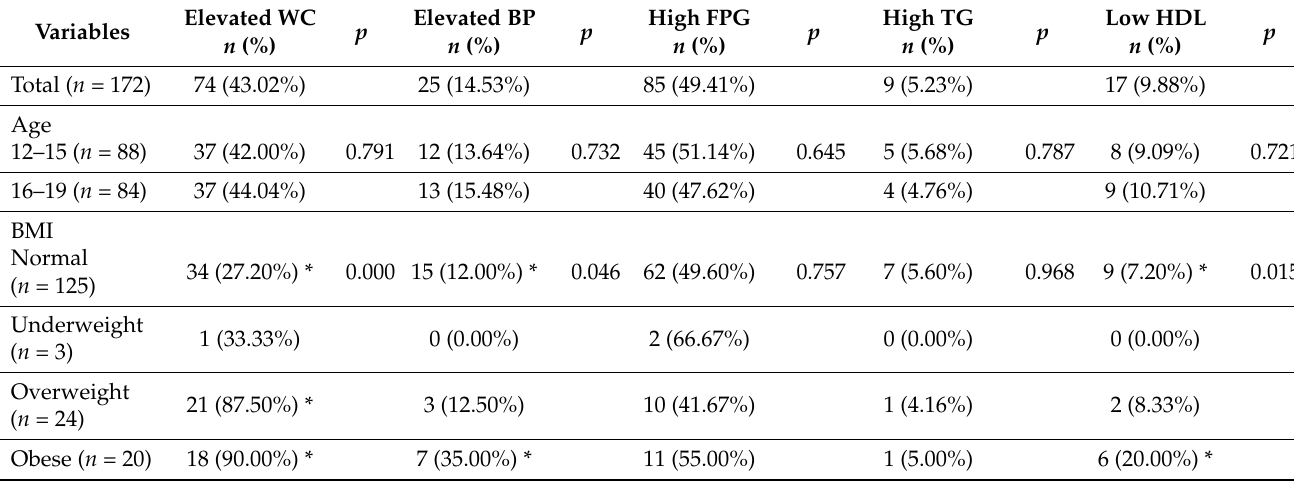
Table 2. Prevalence of individual Metabolic Syndrome risk factors among female adolescents aged 12–19 years.